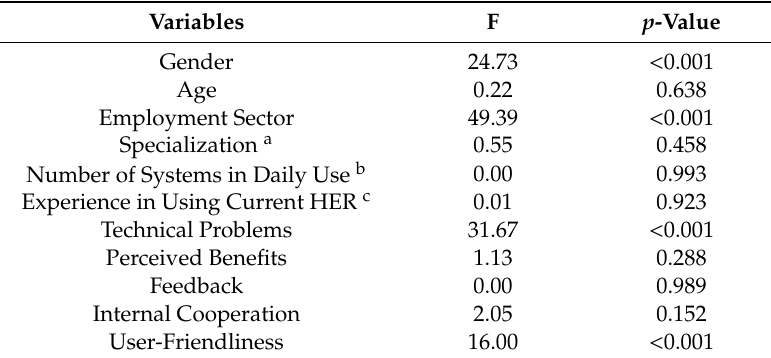
Table 2. The results of the analyses of covariance for time